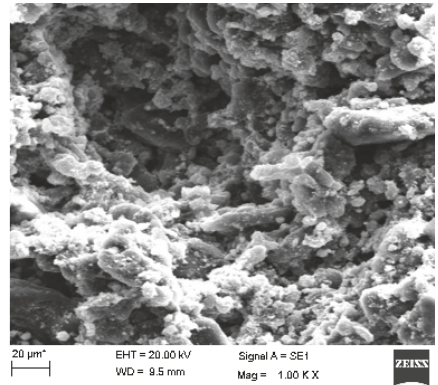
Figure 5: Representing Scanning Electron Microscopic image of AChE/SnO 2 -cMWCNTs/Cu.